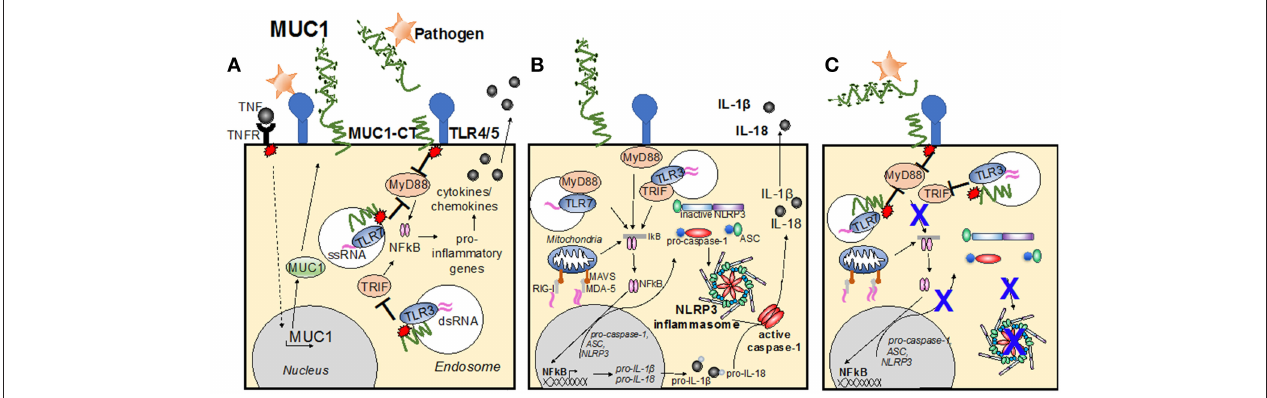
FIGURE 2 | Modes of MUC1 control of cellular inflammatory signaling pathways. (A) Infection causes TLR activation, causing production of inflammatory mediators, such as TNF. In turn, MUC1 is upregulated and suppresses TLR signaling, attenuating inflammation. Direct binding of pathogen to MUC1-ED induces phosphorylation of the MUC1 cytoplasmic tail, increasing MUC1-CT association with TLRs at the cell surface, or within the endosome, competitively inhibiting recruitment of MyD88 and/or TRIF to the TLR and blocks downstream signaling. (B) Upon detection of PAMPs by PRRs at the cellular membrane and within the endosome, the TLR becomes activated and induces the NF-kB transcription pathway, resulting in upregulation of pro-IL-1 β , pro-IL-18 and pro-caspase-1, ASC and NLRP3. A second stimulus then causes NLRP3 to nucleate ASC, inducing the characteristic speck-like structure and causes caspase-1 activation. Active caspase-1 cleaves the pro-IL-1 β and pro-IL-18, creating the active cytokines IL-1 β and IL-18, which are then secreted from the cell. (C) Activation of the MUC1-CT after interaction with pathogen causes recruitment to the TLR, and/or subsequent signaling that limits TLR activation of the signaling cascade and blocks upregulation of inflammasome components. Whether MUC1-CT interacts with NLRP3 directly remains to be